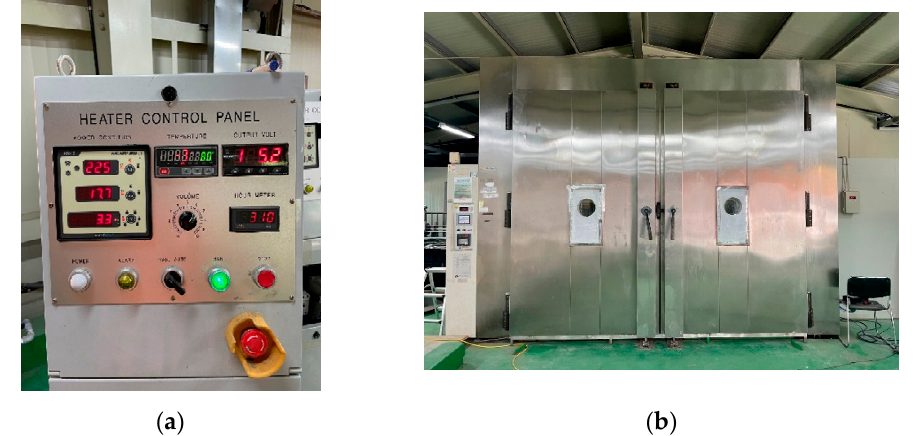
Figure 5. The voltage control device ( a ) and the test chamber ( b ).